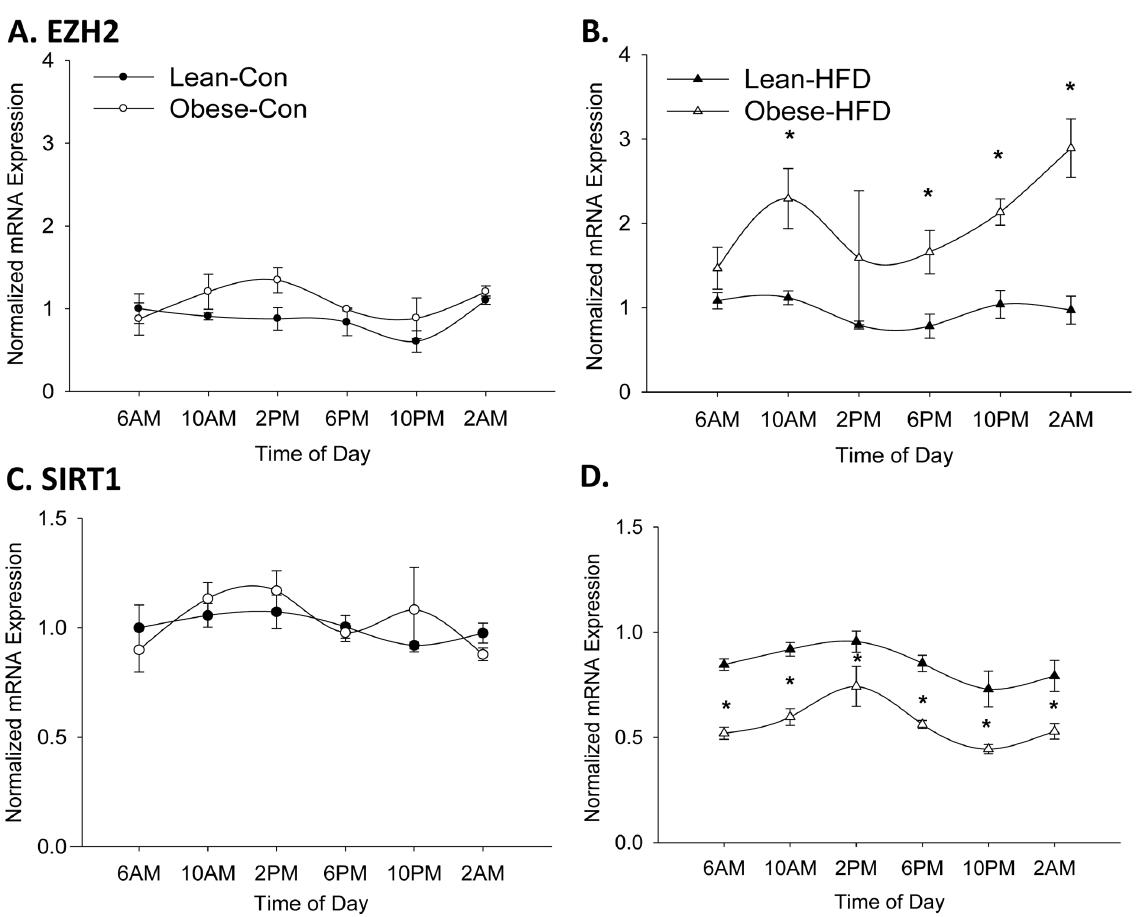
Figure 6. Circadian expression of EZH2 and SIRT1 mRNA. Hepatic mRNA expression of EZH2 in A) Control-fed and B) HFD-fed offspring of lean and obese dams at PND35 (N=3–5 animals per group, Lean-Con 2AM and Obese-HFD 6AM (N=5 per group), Lean-Con 10AM and Obese-Con 10PM (N=3 per group), and all the remaining groups (N=4)). C) Hepatic mRNA expression of SIRT1 in Control-fed and D) HFD-fed offspring of lean and obese dams at PND35 (N=3–5 animals per group, Lean-Con 2AM and Obese-HFD 6AM (N=5 per group), Lean-Con 10AM and Obese-Con 10PM (N=3 per group), and all the remaining groups (N=4)). Data are presented as mean 6 SEM. Statistical differences were determined using a Student’s t test. * denotes significance, P ,